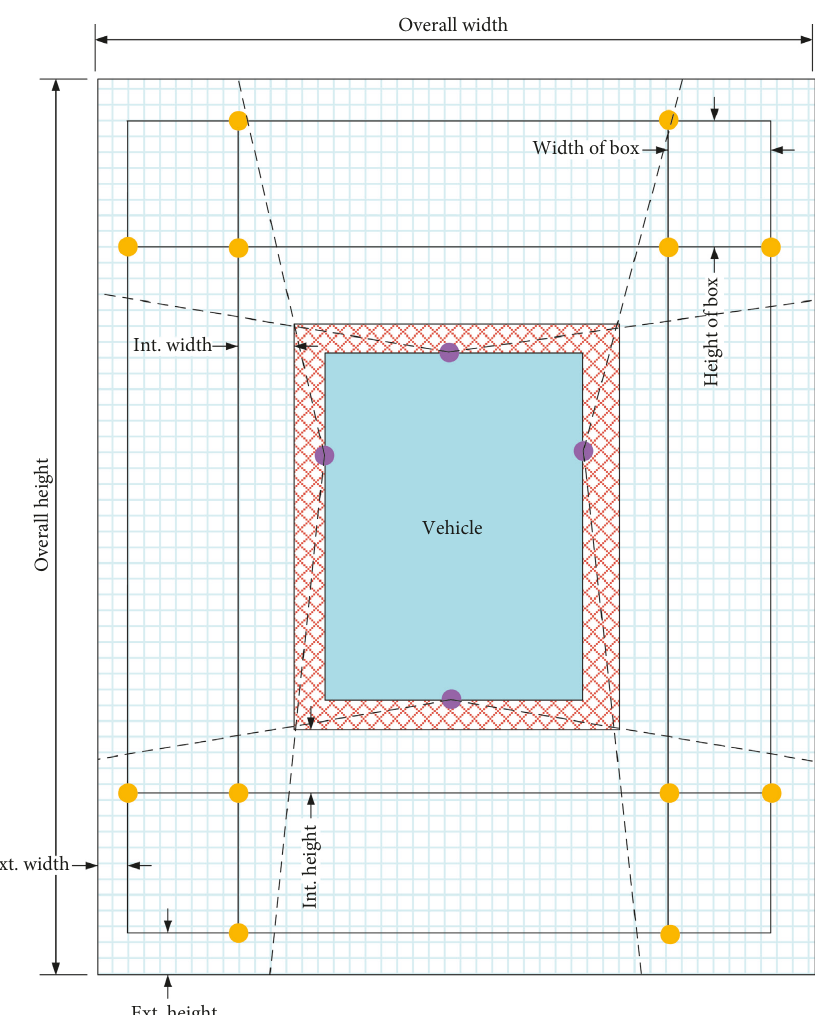
Figure 3: Configuration of four surround-view cameras used in the AVP-SLAM system.